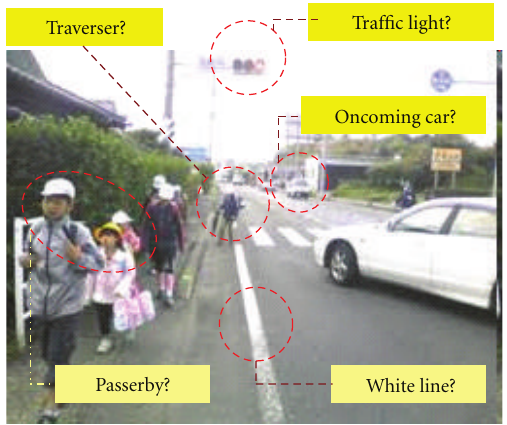
Figure 1: Example of di ffi cult situation to specify environmental factor to estimate intentions: on the